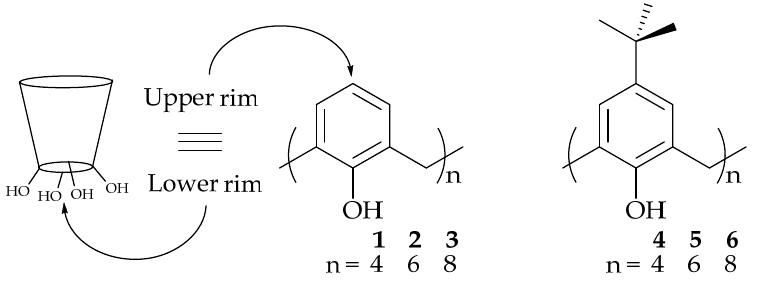
Figure 2. Calix[n]arene derivatives 1 – 6 .